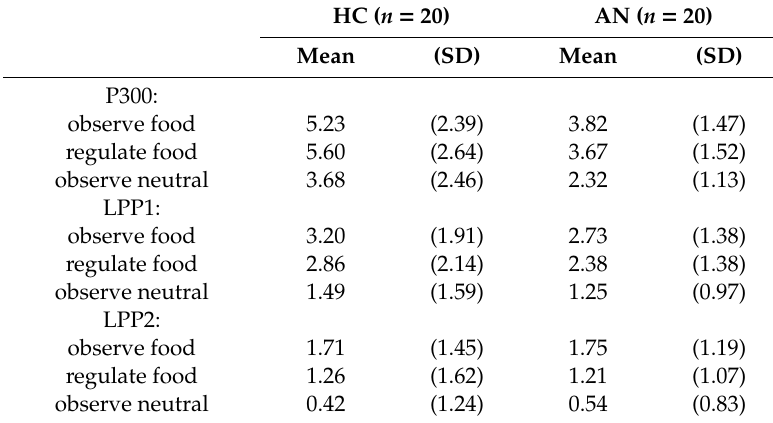
Table 4. Mean (SD) amplitudes ( μ V) of P300, LPP1 and LPP2 during the food craving regulation task.